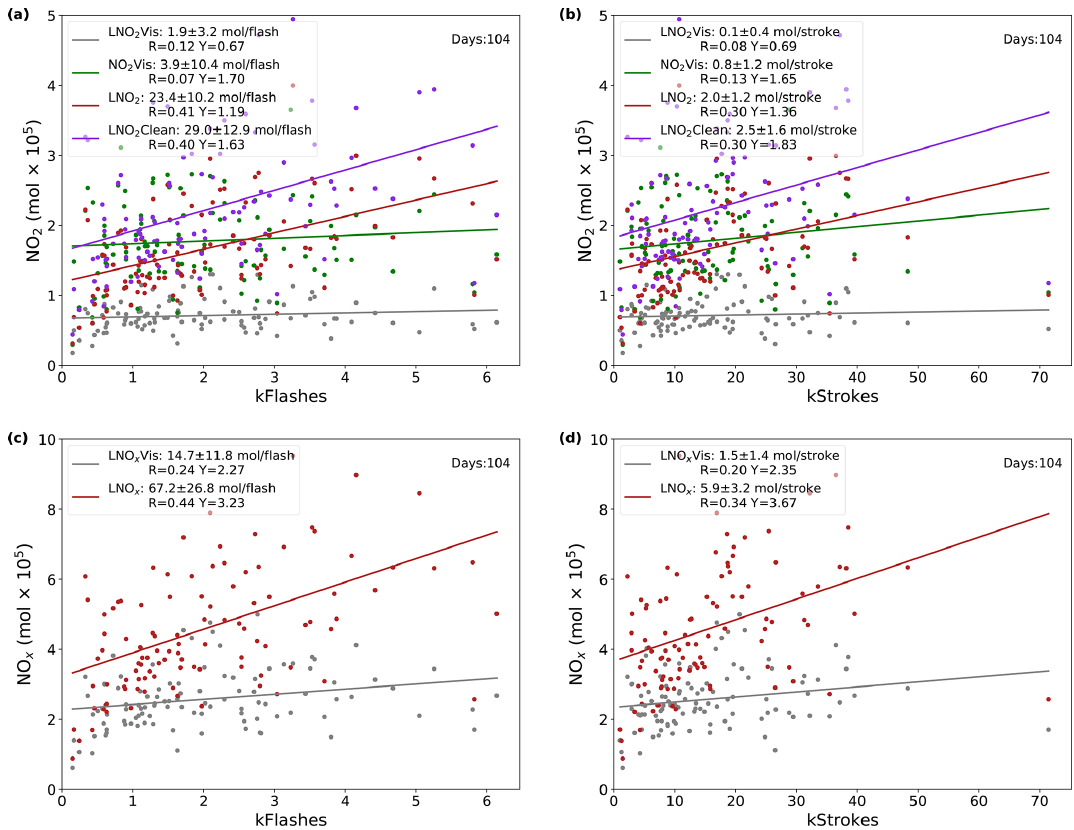
Figure B1. Linear regressions with CRF ≥ 90% and a flash threshold of one flash per box or 3.4 strokes per box per 2.4h. (a) Daily NO 2 Vis, LNO 2 Vis, LNO 2 , and LNO 2 Clean versus ENTLN total flash data. (b) Same as (a) but for strokes. (c) Daily LNO x Vis and LNO x versus total flashes. (d) Same as (c) but for